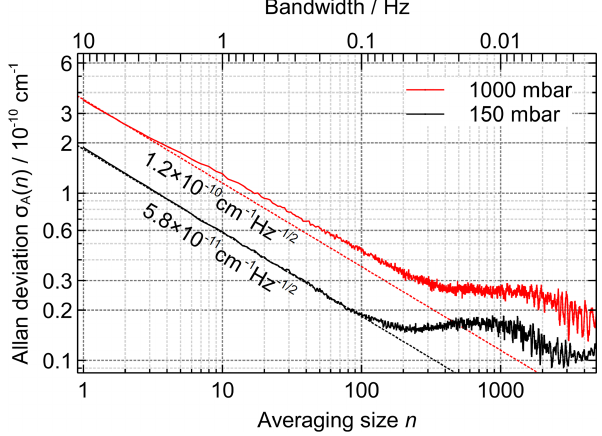
Figure 7. Allan deviation plot of the absorption coefficient at 1506.43nm in the absence of HO 2 against the num- ber of ring-down events averaged, n . For S/N = 2 the min- imum detectable absorption coefficient for a single ring-down measurement is 1.9 × 10 − 10 cm − 1 at 150mbar, which is re- duced to 1.5 × 10 − 11 cm − 1 after averaging 250 ring-down time constants, τ 0 (requiring 25s at an acquisition rate of 10Hz), and 3.6 × 10 − 10 cm − 1 at 1000mbar, which decreases to 2.7 × 10 − 11 cm − 1 after n = 600 (requiring 60s at an acquisition rate of